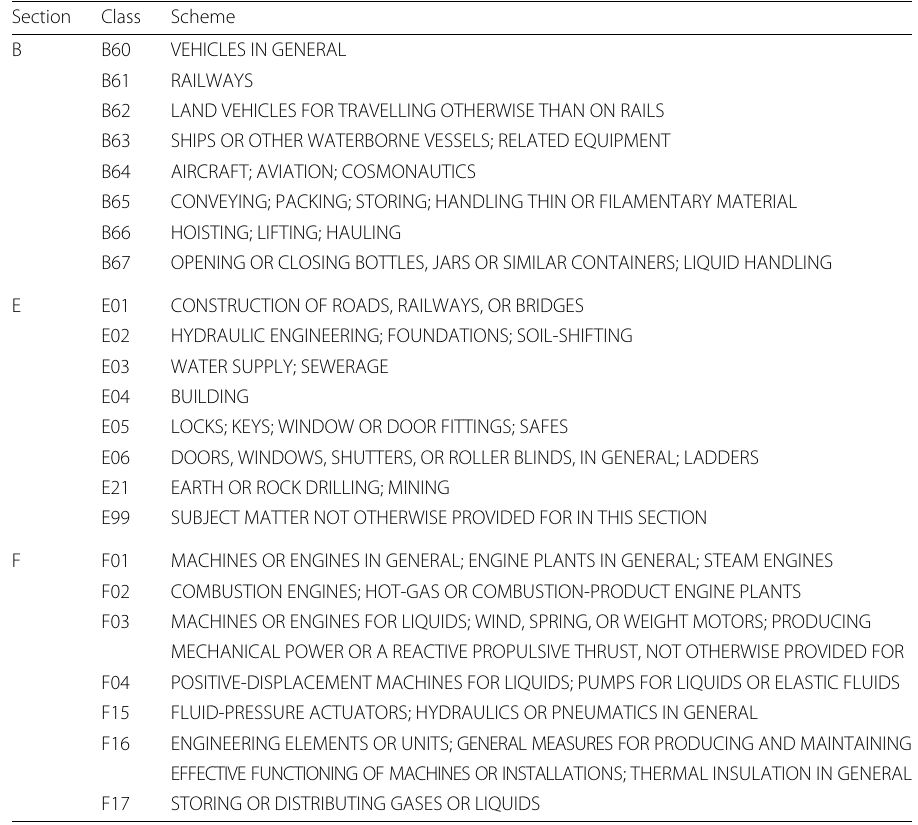
Table 1 IPC schemes of the persistent technologies in community containing B60R